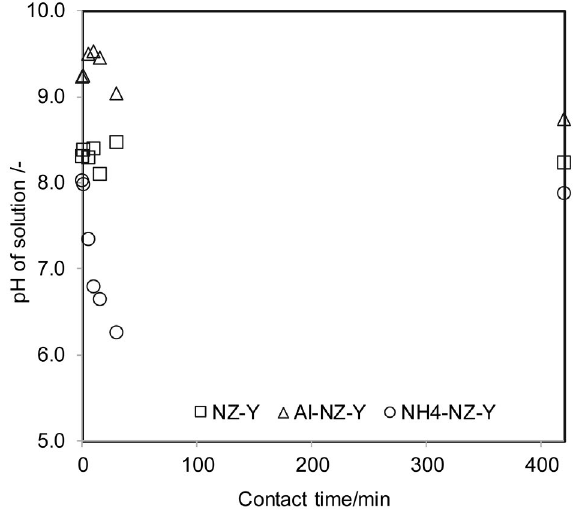
Figure 1. pH variation of solution with